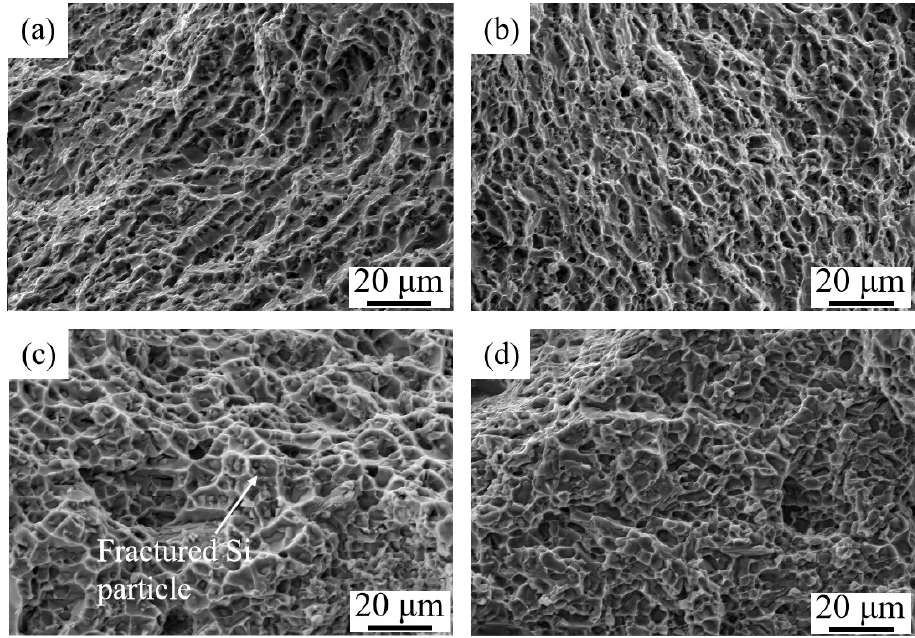
Figure 8. Fracture morphology of tensile tested specimens: ( a ) X direction of the as-deposited samples; ( b ) Z direction of the as-deposited samples; ( c ) X direction of the T6 heat-treated samples; ( d ) Z direction of the T6 heat-treated samples.